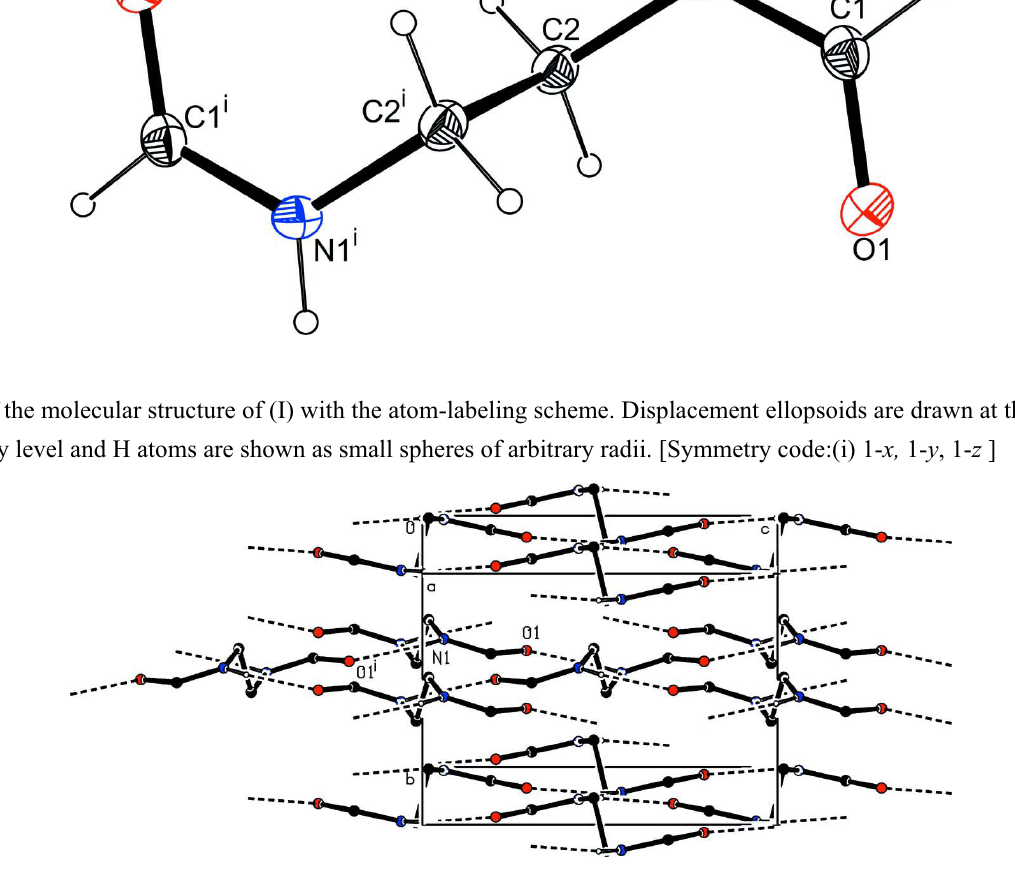
Figure 2 Partial packing view showing the formation of the two dimensional network through N-H···O hydrogen bonds which are shown as dashed lines. H atoms not involved in hydrogen bonding have been omitted for clarity. [Symmetry code: (i) - x+1/2, -y+1, z-1/2] N